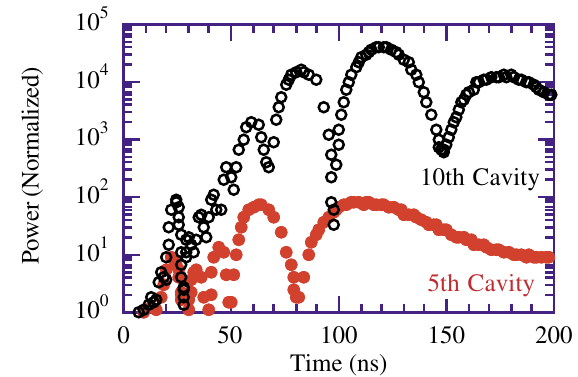
FIG. 4. (Color) Simulation of expected growth of the trans- verse instability as a function of time during the beam pulse for two different cavities. Phase advance per cavity (cid:2) 310 (cid:1) .